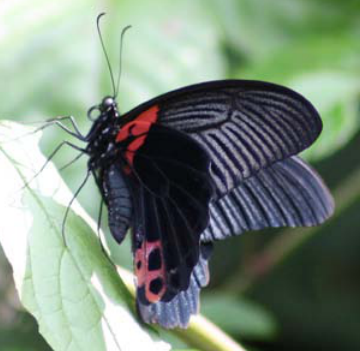
Image 22. Papilio memnon agenor